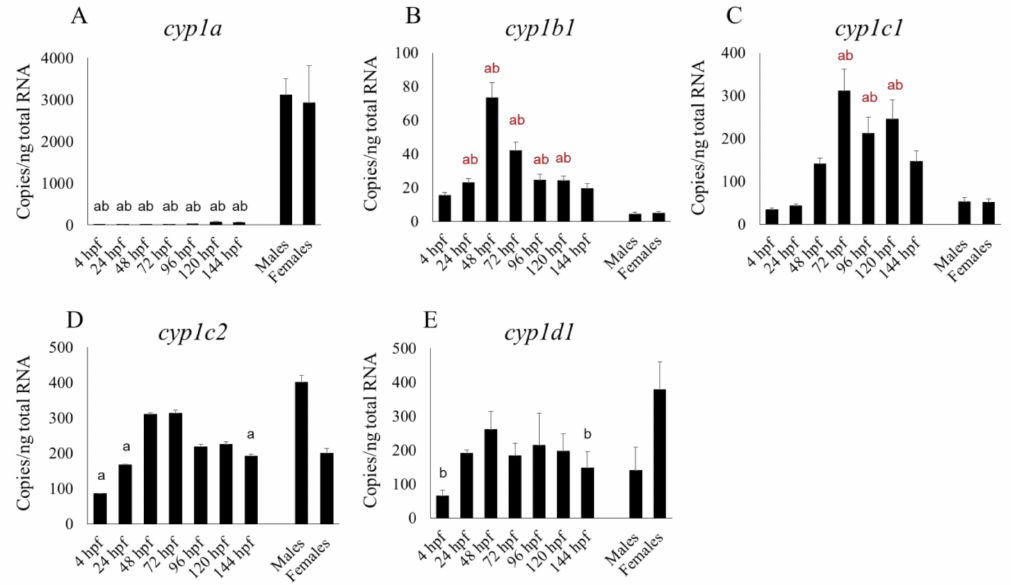
Figure 1. Developmental expression of five mRNAs of cyp1 isoforms in zebrafish whole embryos and larvae from 4 to 144 h post-fertilization (hpf) in comparison with their expression in the livers of adults of both sexes. Results of cyp1a ( A ), cyp1b1 ( B ), cyp1c1 ( C ), cyp1c2 ( D ) and cyp1d1 ( E ) are shown. “a” indicates a significant ( p < 0.05) di ff erence compared with male livers and “b” is a significant ( p < 0.05) di ff erence compared with female livers. Black letters indicate significantly lower expression in embryos or larvae compared with adult livers, and red letters indicate significantly higher expression in embryos or larvae compared with adult livers. n =